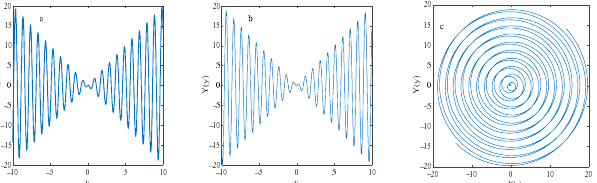
Figure 7. A typical plot of the dynamic spiral system when a = 2, b = π solutions of X(y) ( a ), Y(y) ( b ) and spiral system ( c ).